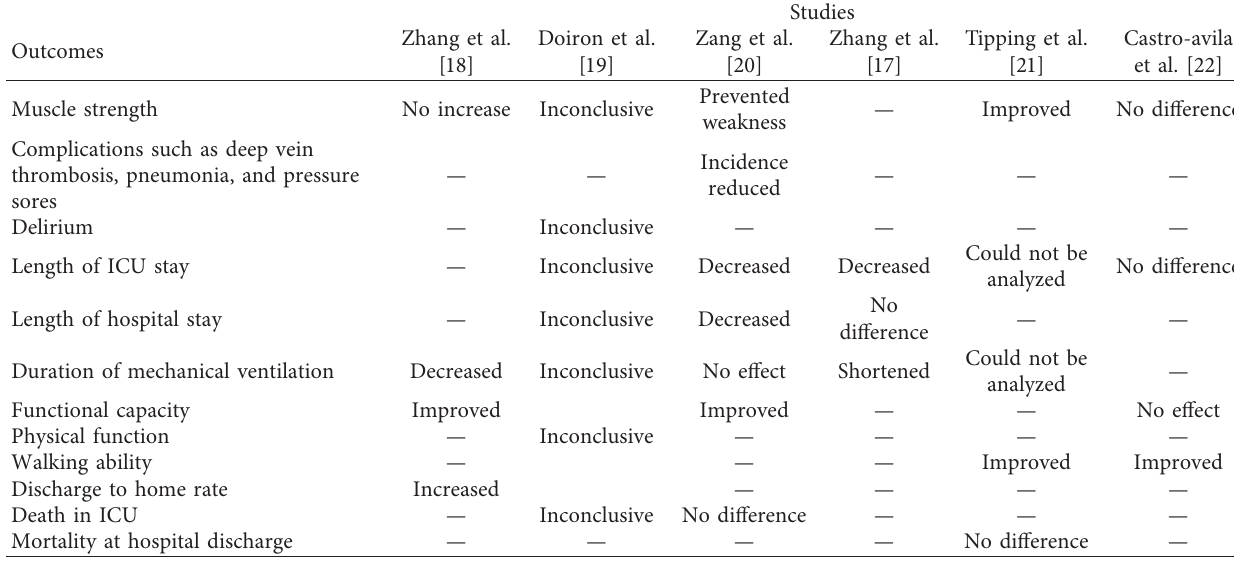
Table 1: Short-term impact of early mobilization on outcomes.